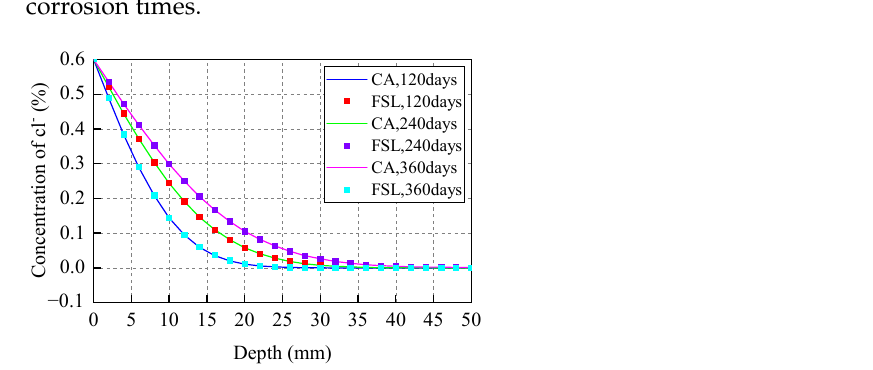
Figure 4. Chloride ion concentration distribution in concrete determined by CA and FSL methods.